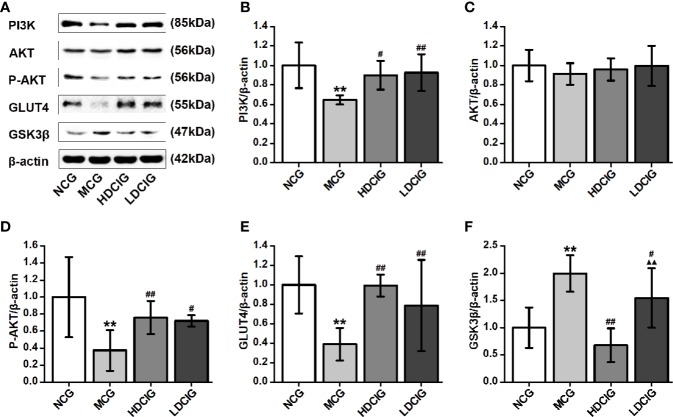
Effects of D-chiro-inositol (DCI) on the expression level of PI3K/AKT/GLUT4/GSK3β signal pathway-related proteins in the liver tissues of db/db mice. (A) Representative immunoblots of phosphatidylinositol 3–kinase (P13K), protein kinase B (AKT), phosphor-AKT (S473) (P-AKT), glucose transporters 4 (GLUT4), glycogen synthase kinase 3β (GSK3β), and β-actin are listed. Our samples were derived from the same experiment and blots were processed in parallel. (B) The result of PI3K protein expression. (C) The result of AKT protein expression. (D) The result of P-AKT protein expression. (E) The result of GLUT4 protein expression. (F) The result of GSK3β protein expression. Grayscale value was determined using Image J based on immunoblot bands (n=3). The results obtained for the different groups were normalized to those reported in the normal control group (NCG). All values are expressed as means ± SD. **P < 0.01 vs. (NCG) mice; #P < 0.05, ##P < 0.01 vs. model control group (MCG) mice; ▲▲P < 0.01 vs. high-dose D-chiro-inositol group (HDCIG) mice.